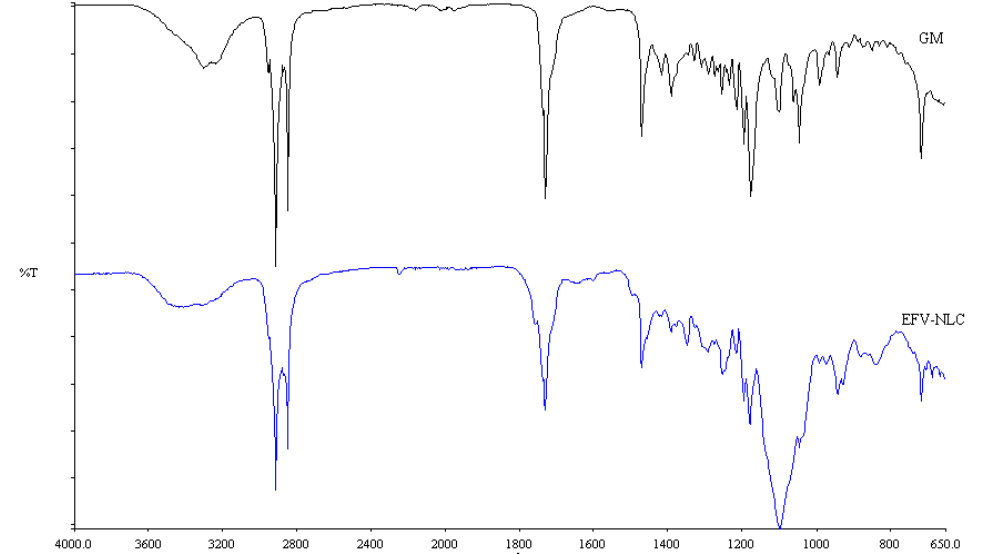
Figure 11. FT-IR spectra of optimized EFV-loaded NLC and GM after exposure to heat .